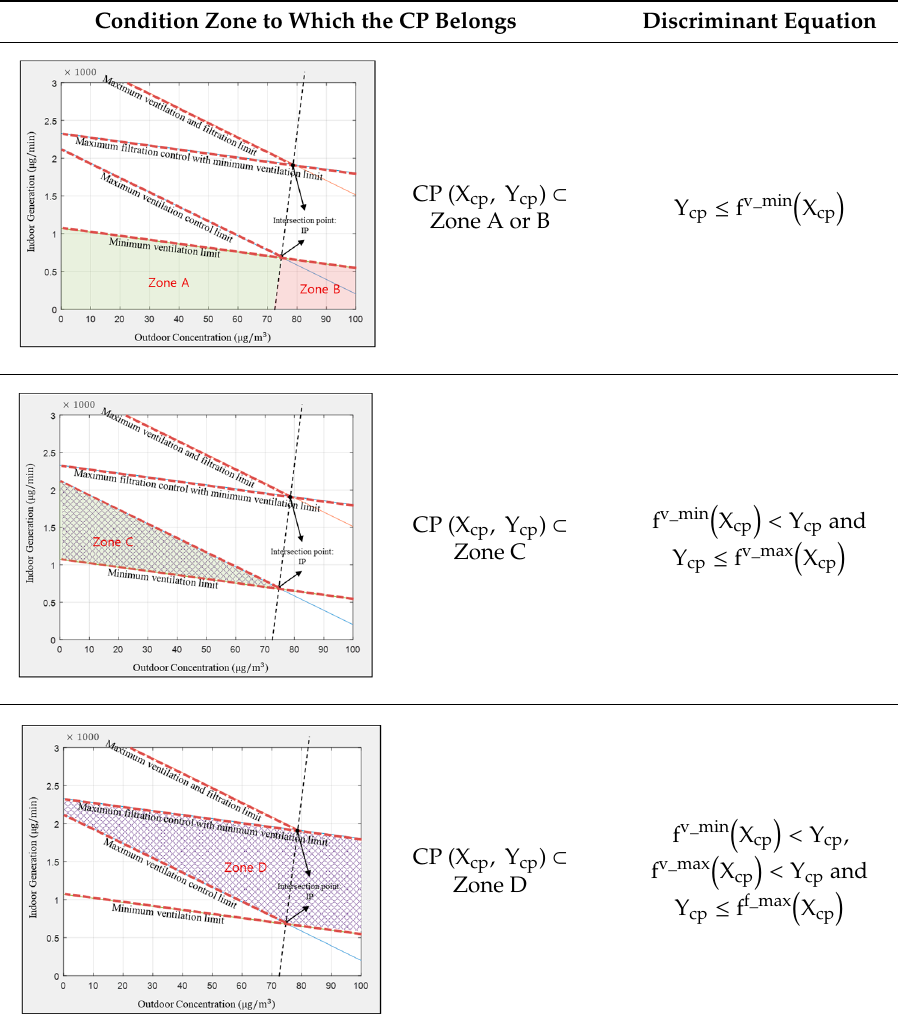
Table 4. Discriminant equation for identifying the condition zone to which the condition point (CP) belongs.